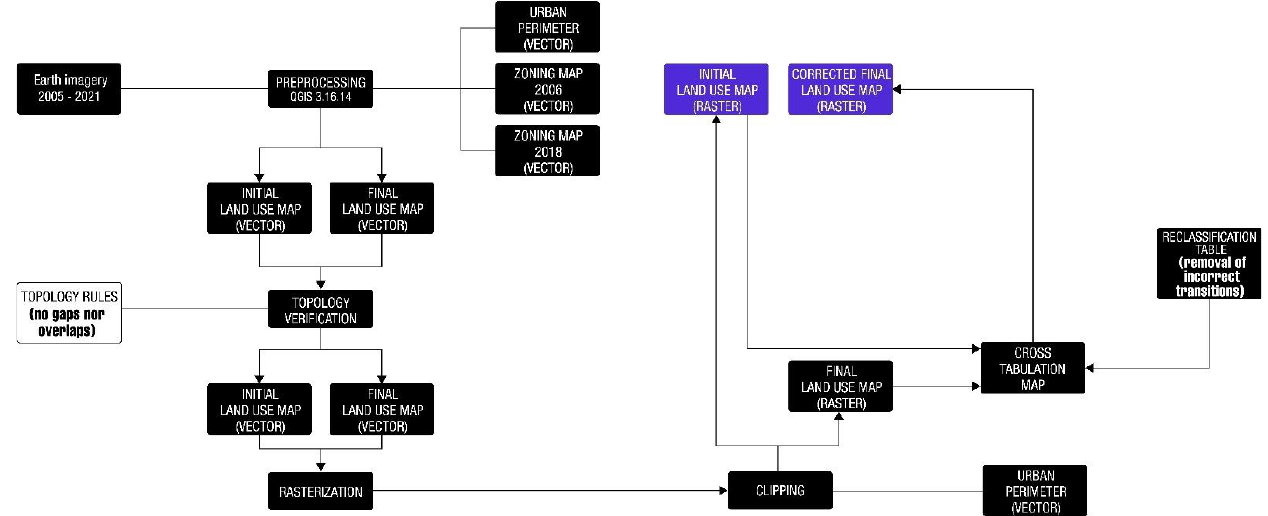
Figure 4. Flowchart of the land use maps ’ generation process. Table 1. Land use transitions observed in the analyzed simulation periods. The colors are associ- ated with the respective classes in the land use maps.